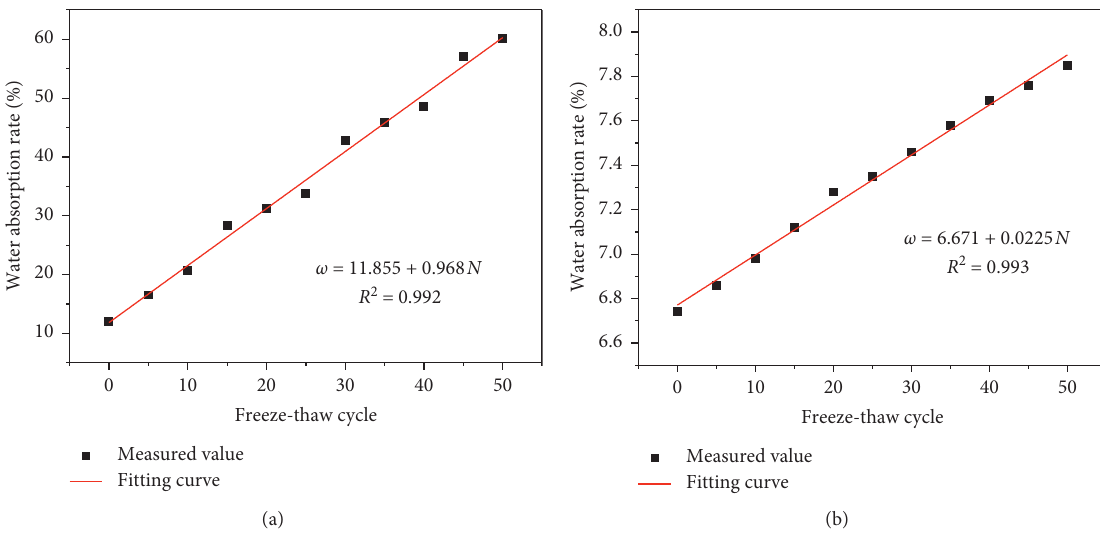
Figure 7: Effect of freeze-thaw cycles on water absorption of insulation materials. (a) Polyphenolic (b) Polyurethane.